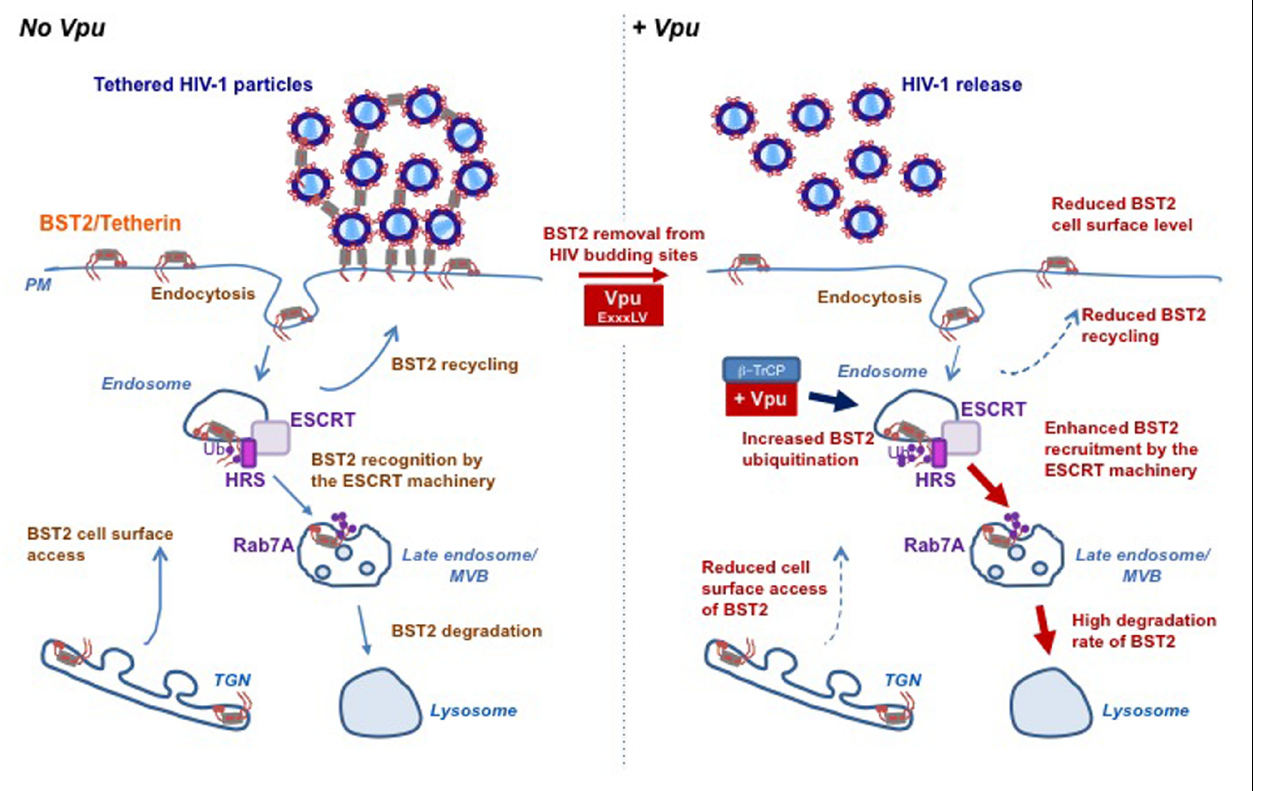
restores viral release.Vpu down-regulates cell surface BST2 by slowing down the PM access of internalized and newly synthesized BST2.Vpu-induced BST2 cell surface down regulation is associated with targeting of the restriction factor for lysosomal degradation through an ubiquitin-dependent mechanism that involves the recruitment of SCF ß-TrCP E3 ubiquitin ligase complex and the ESCRT machinery. Indeed, through binding to HRS,Vpu enhances the affinity of BST2 for HRS thus accelerating its sorting by the ESCRT machinery for lysosomal degradation. One might propose that through binding with the ESCRT machinery,Vpu may favor the sorting of BST2 at the level of endosomes, thereby reducing its recycling to the plasma membrane (right panel).This figure is adapted from Janvier etal.